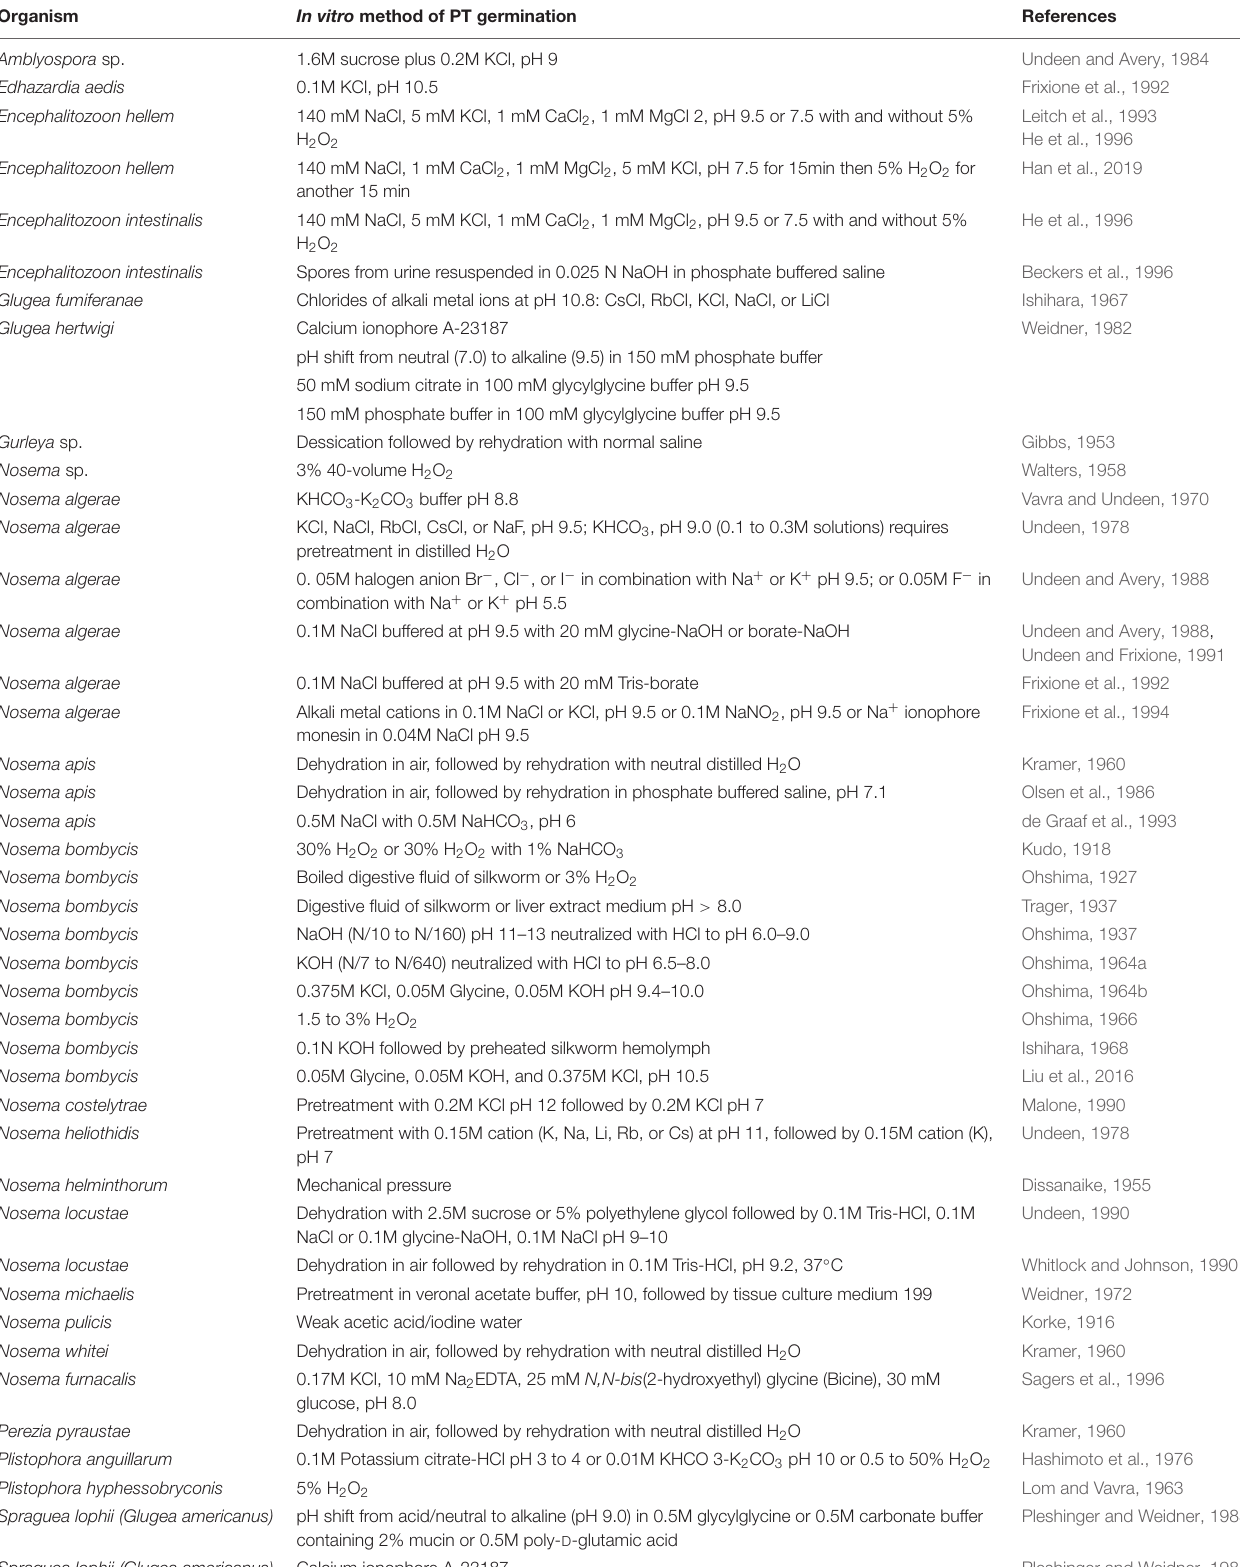
TABLE 2 | Conditions for activation and discharge of polar tubes. Organism In vitro method of PT